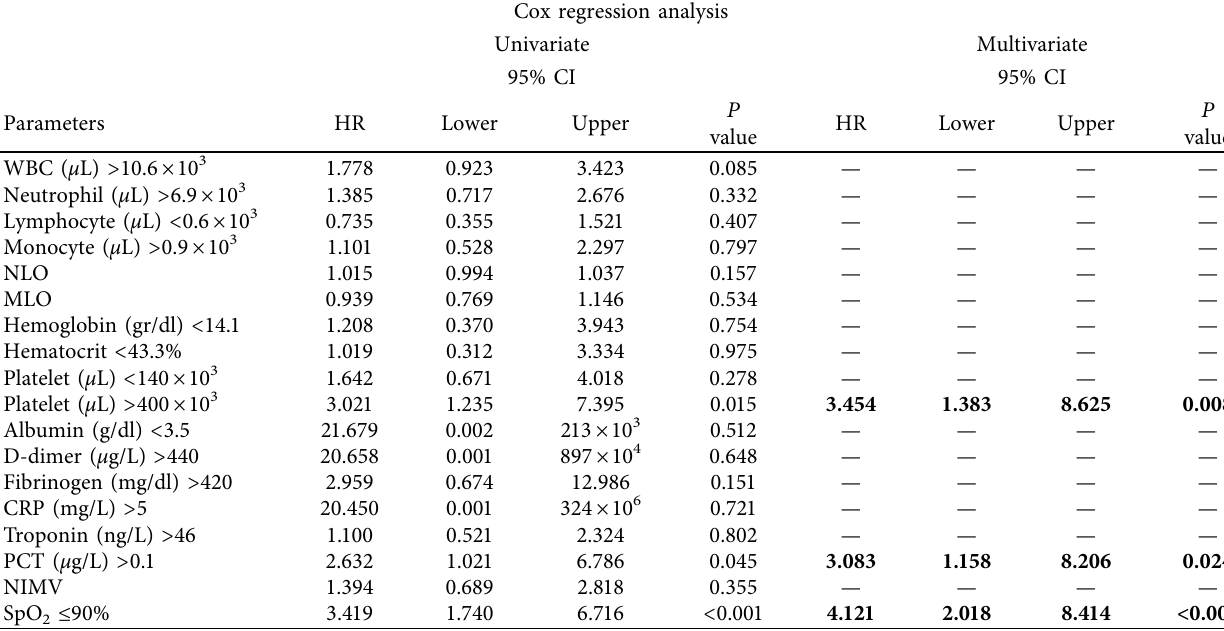
Table 3: Univariate and multivariate Cox regression analysis and parameters on admission predicting